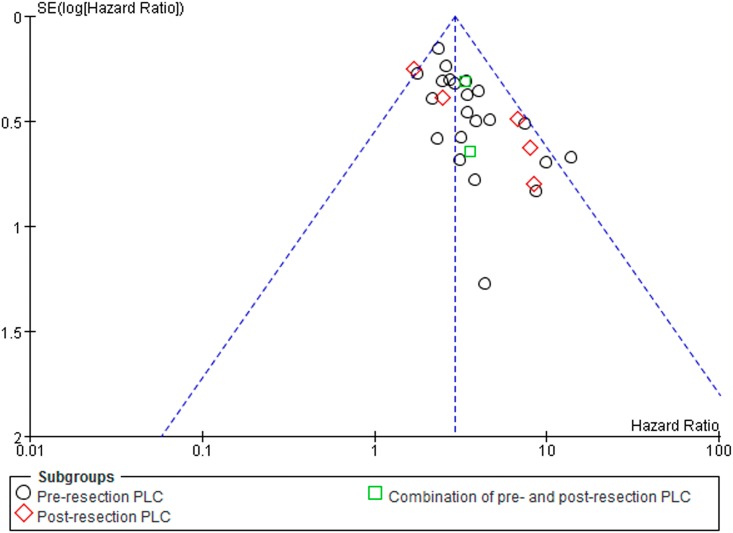
Funnel plots for publication bias for HR of overall survival rate.